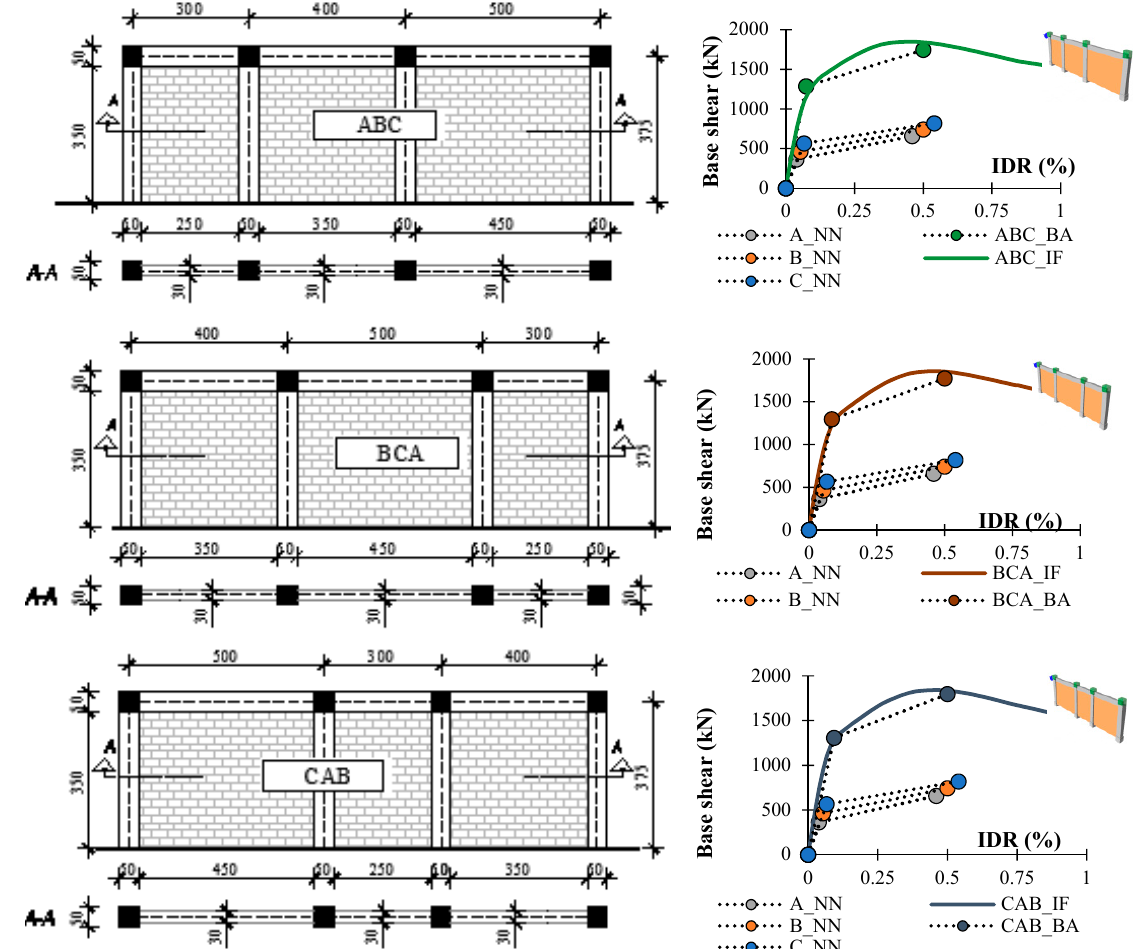
Figure 11. Multi-bay frame models and capacity curves for multi-bay frames with different bay length. Table 11. Evaluation of accuracy of proposed bilinear approximation equations for di ff erent bay length for frames with three